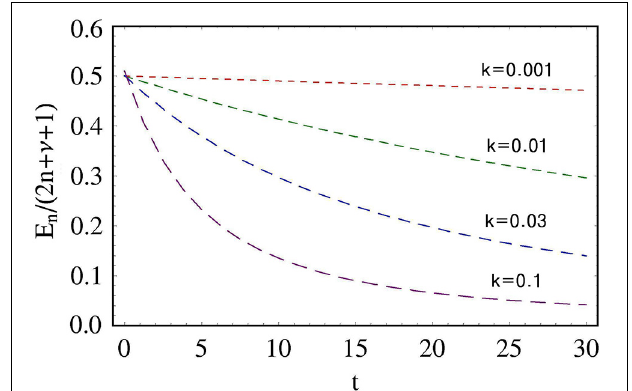
FIGURE 1 | Time evolution of the radial energy expectation values divided by (2 n + ν + 1) with the choice of B ( t ) as Equation (31). The values we used are ¯ h = 1, m = 1, q = 1, and B 0 = 1. All these values are taken to be dimensionless for convenience.